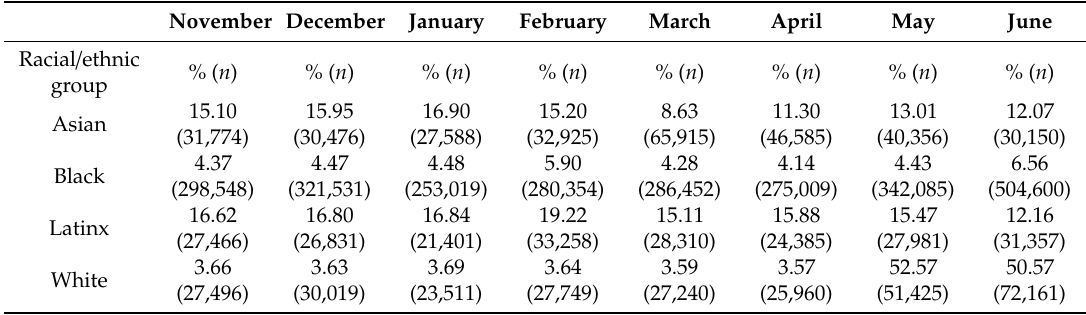
Table 2. Percent of tweets referencing racial and ethnic groups that are positive by month,